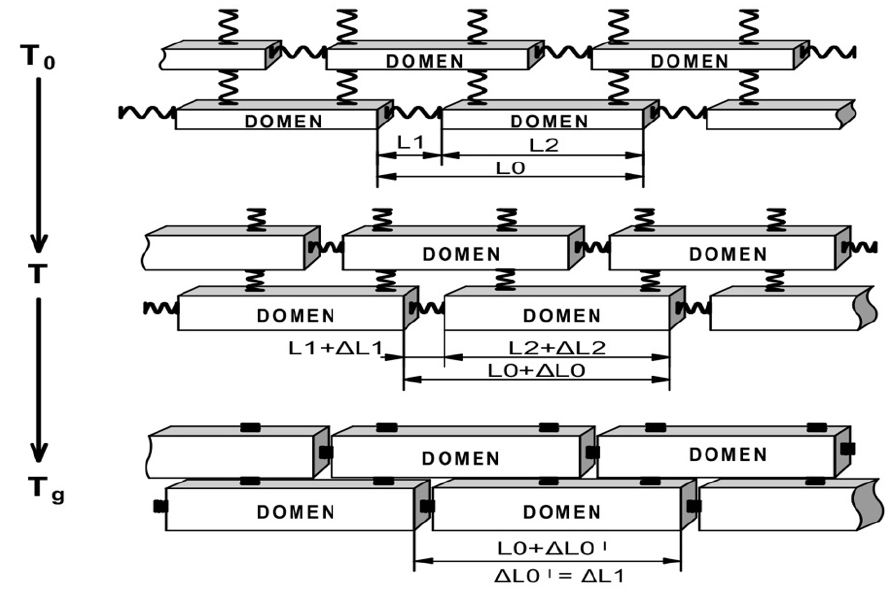
Figure 8. Compensative model of GP expanding under heating.